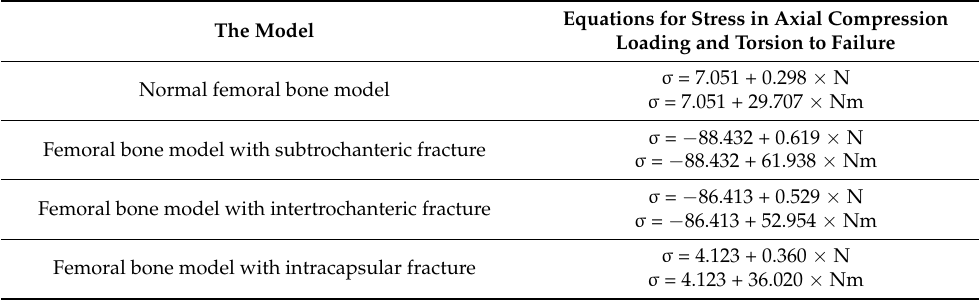
Table 3. Equations for stress in axial compression loading and torsion to